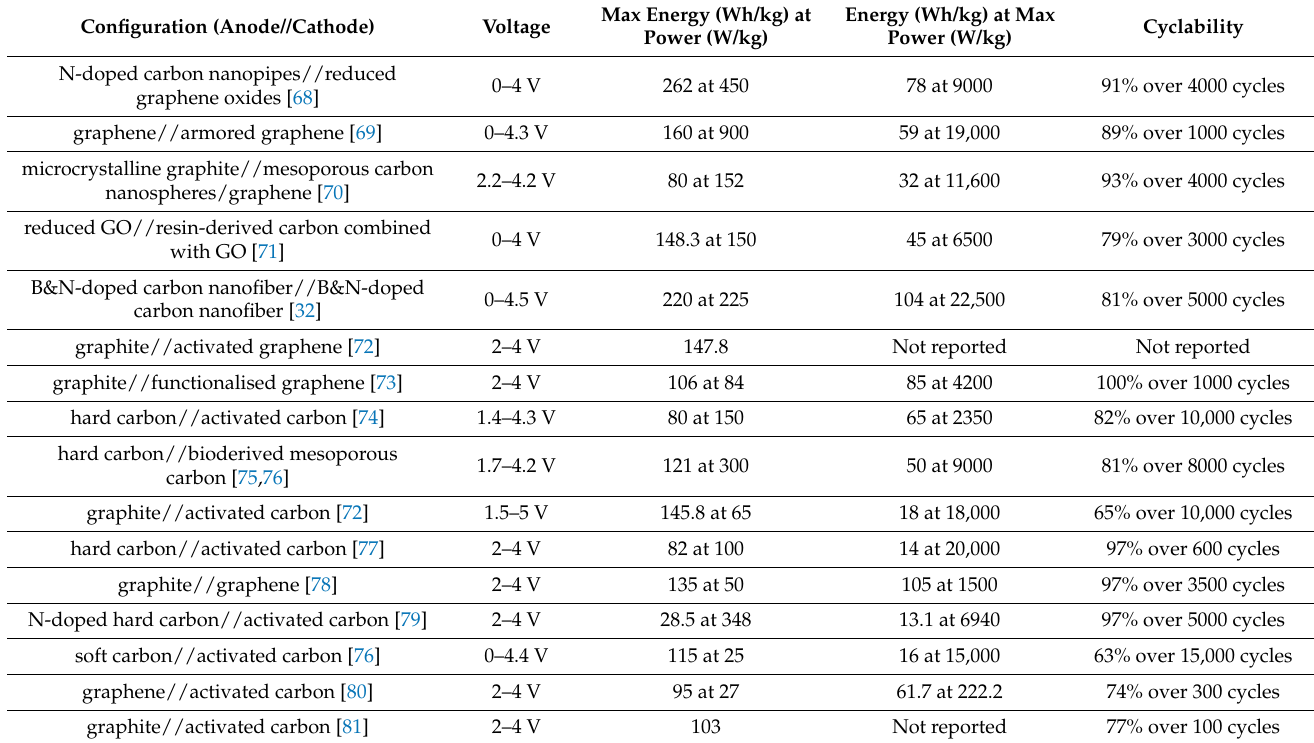
Table 1. Carbonaceous material-based lithium-ion capacitor (LIC)